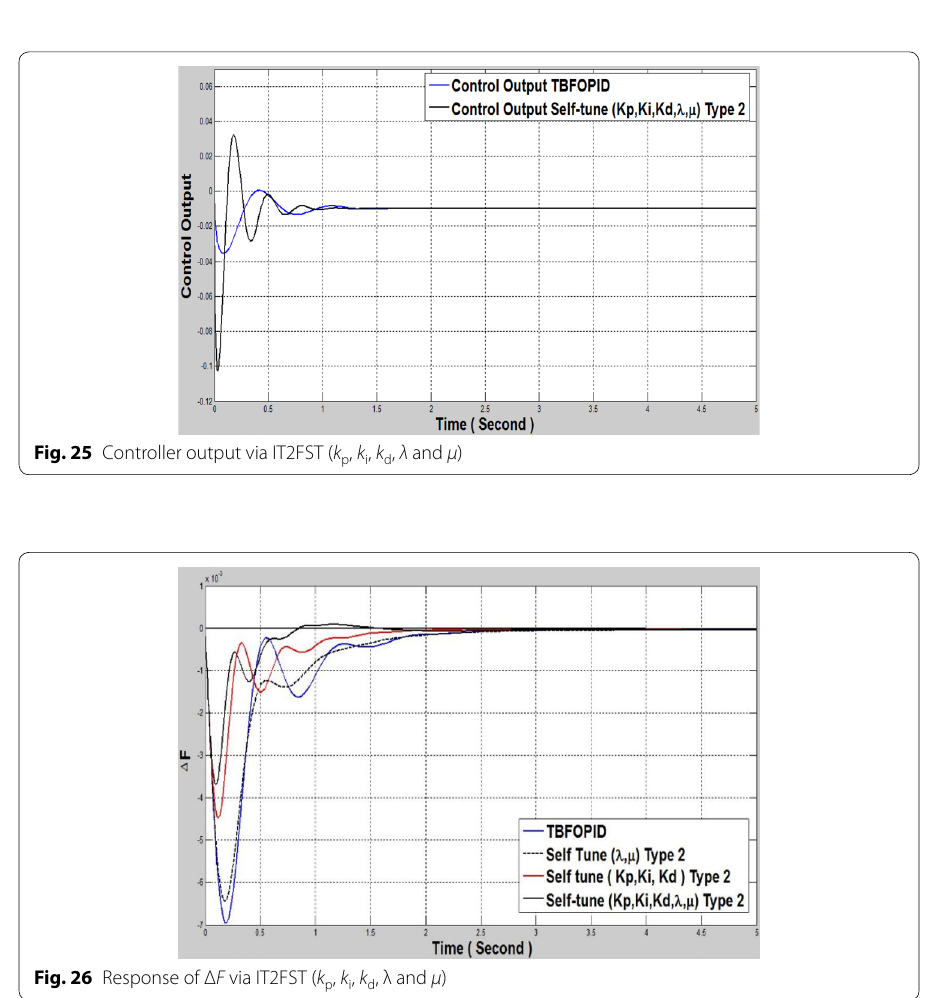
Case 5: Comparison between IT2FST and T1FST for TSMFOPID